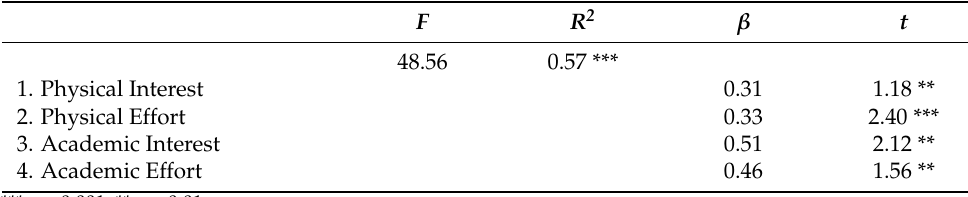
Table 4. Linear Regression